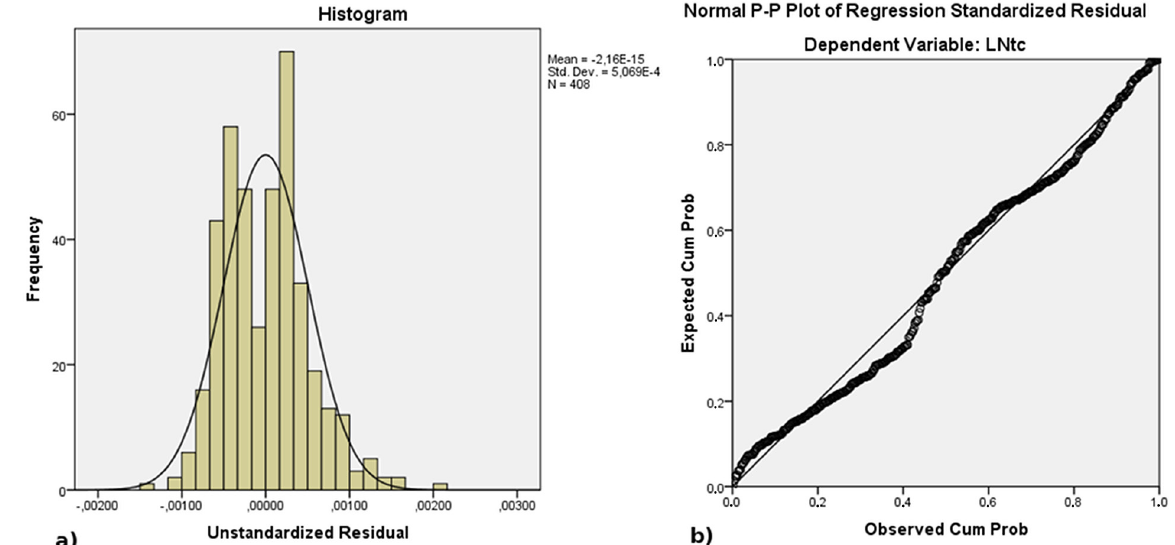
Figure 5 - a ) Histogram with normal distribution of the residuals of the fitted ETo model for the IRW, and b ) observed and expected probabilities of the ETo model for the